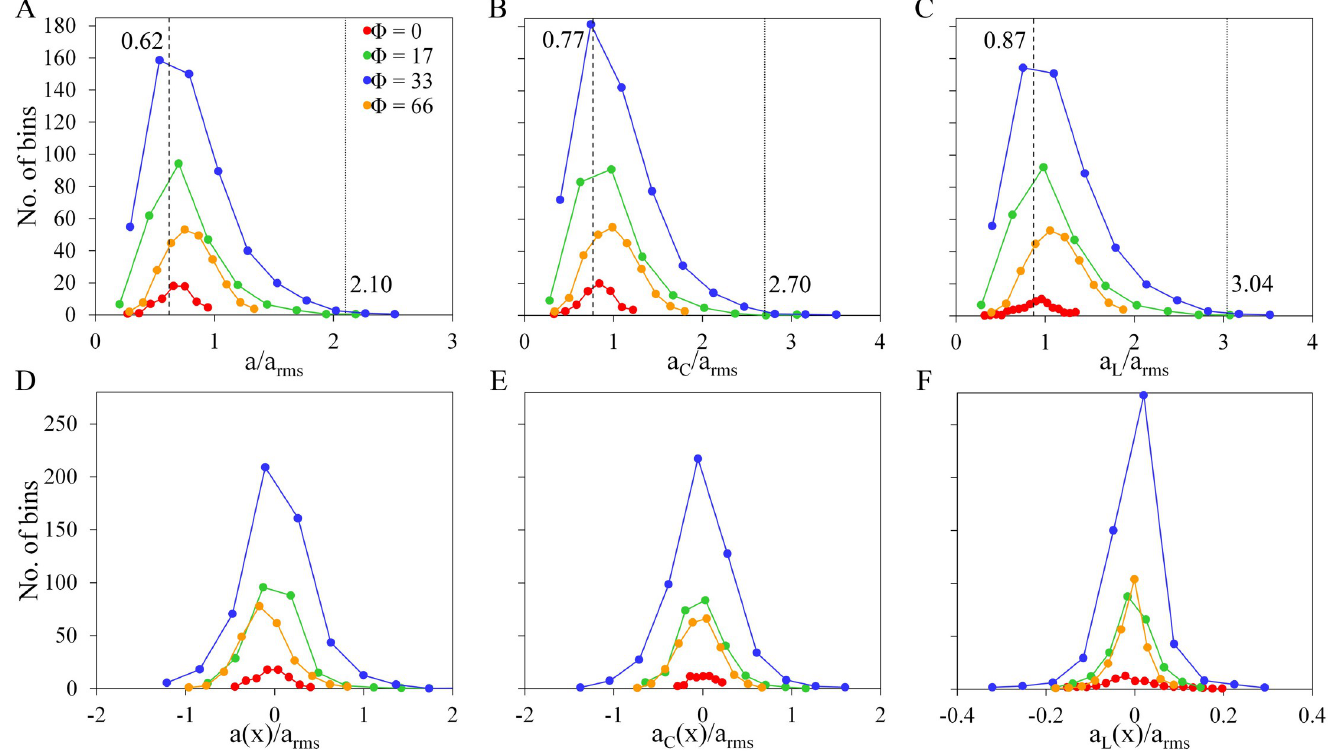
Fig 7. Histogram of the magnitudes and x -components of acceleration when Re λ = 59. The number of bins (cube) per acceleration value for the magnitudes of (A) acceleration, (B) centripetal acceleration, and (C) longitudinal acceleration. (D-F) corresponds to the x -components of the three accelerations.